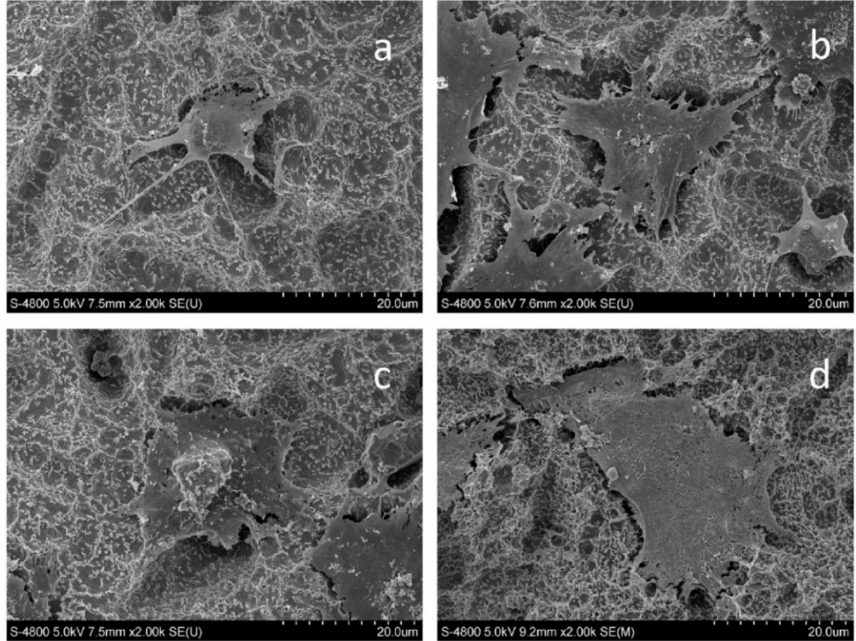
Figure 12. SEM figures of MC3T3-E1 cells on the surfaces of CP Ti ( a , b ) and UFG Ti ( c , d ). In these images, ( a , c ) and ( b , d ) show cell adhesion after 2 and 24 h of incubation, respectively, adapted from [10], with permission from Elsevier, 2020.